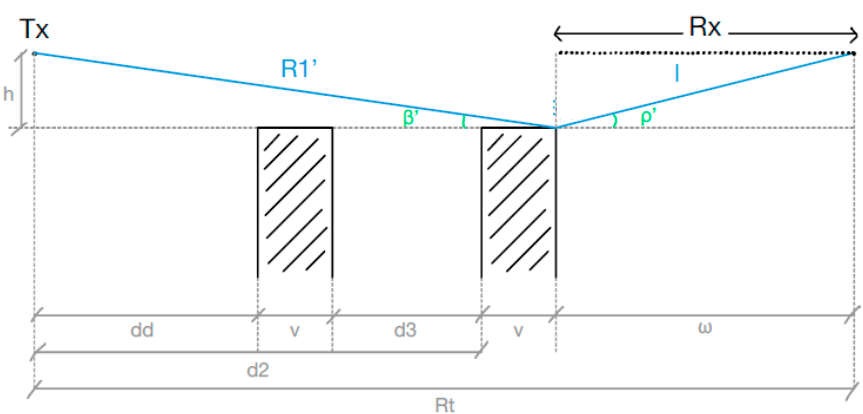
Figure 5. Third single diffraction (Edif3) of the considered LOS scenario.